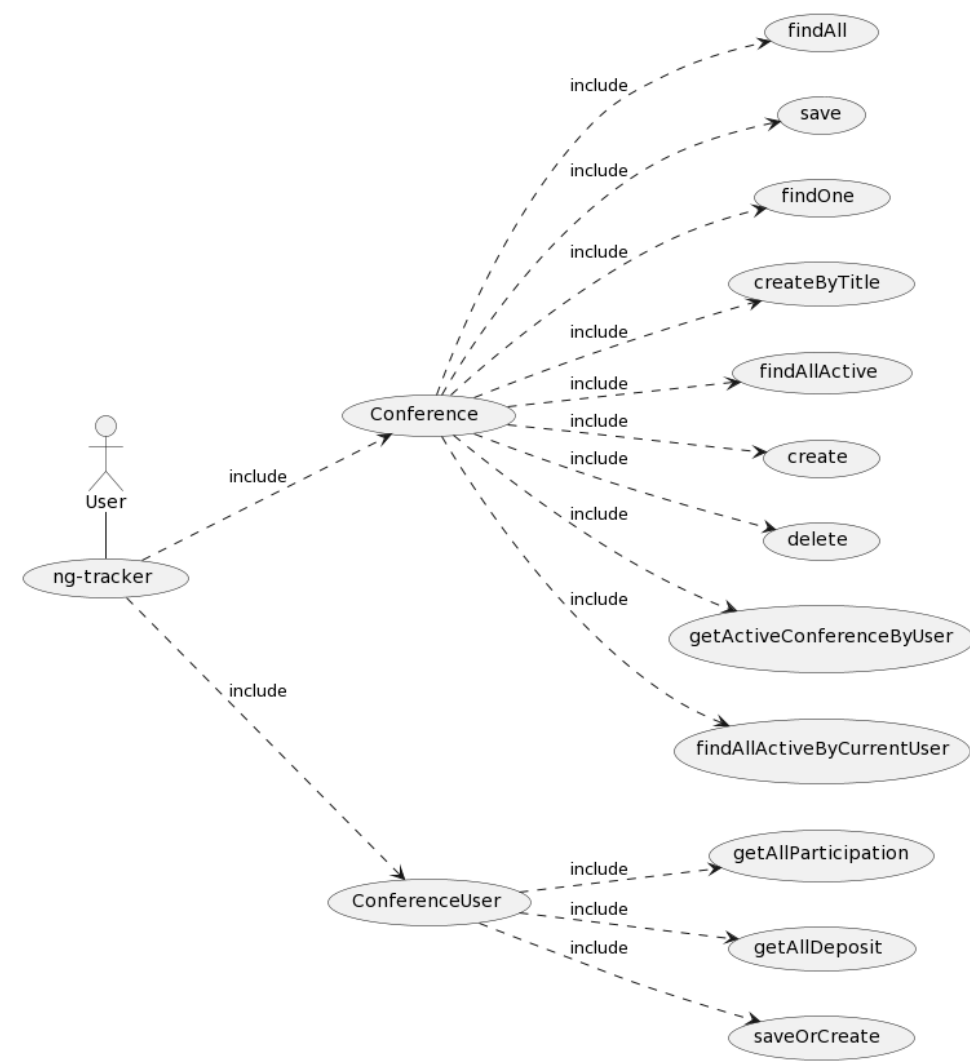
Figure 10. Example of the use case diagram for the ng-tracker project generated with the PlantUML